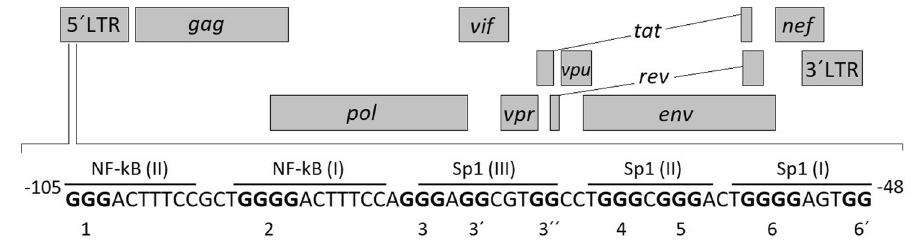
Figure 1. HIV-1 genomic organization and a sequence of the G-rich LTR region spanning nucleotides − 105/− 48. The lines indicate transcription factor binding sites. The G bases involved in the formation of G-quadruplexes are in bold and G-tracts are